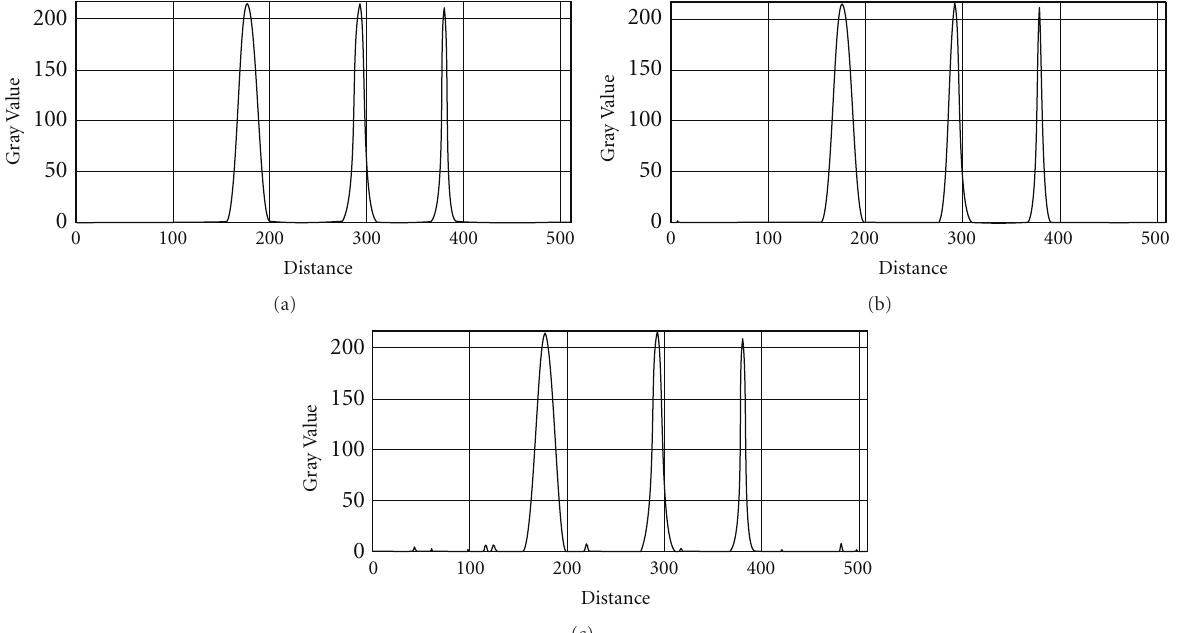
version. The amount of CPU time spent for a single run in non-automatic mode is 58 minutes whereas for automatic mode is 64 minutes, which is just about 10%